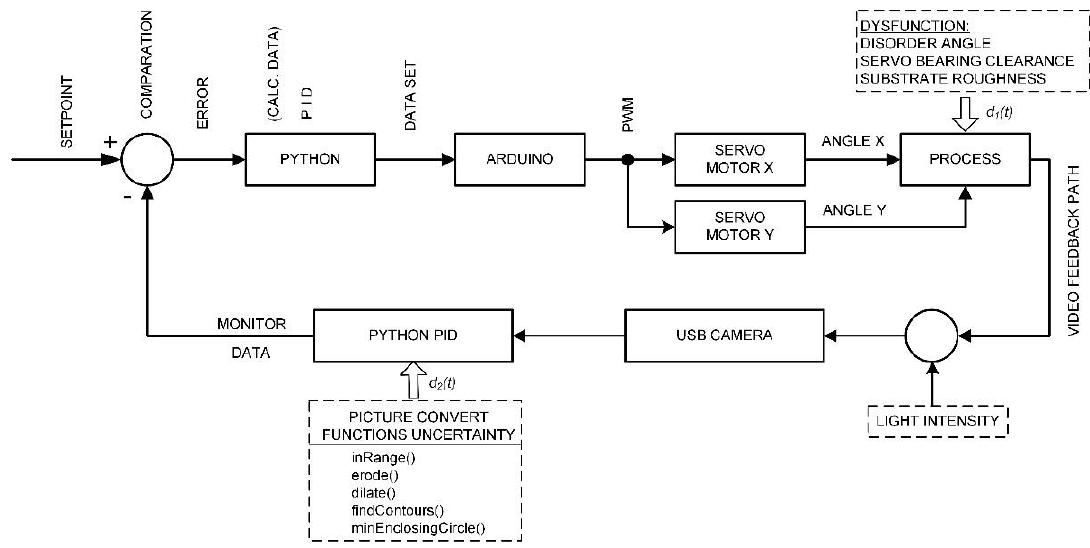
Figure 14. Advanced CLC control diagram scheme.